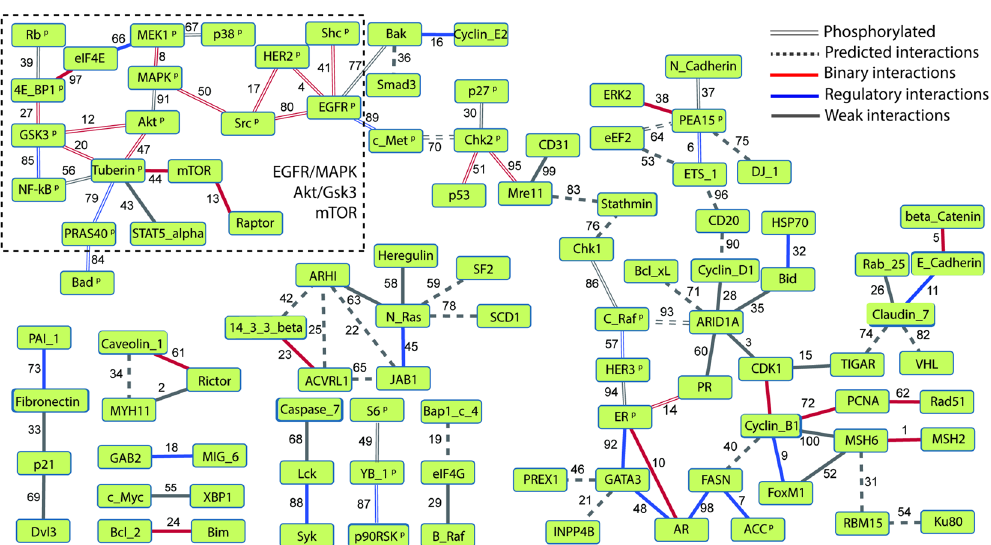
Figure 3. Visualization of pan cancer protein coupling network based on top 100 pairs ranked by DI values. Interactions are colored based on the interaction category, with red solid edges indicating binary interactions , blue solid edges indicating regulatory interactions , grey solid edges indicating weak interactions , and grey dashed edges indicating the predicted interactions . The double solid edges regardless of the color indicate that these interactions involve phosphorylated proteins with superscript of ‘P’. The edge coefficients represent the ranking by using direct information as a